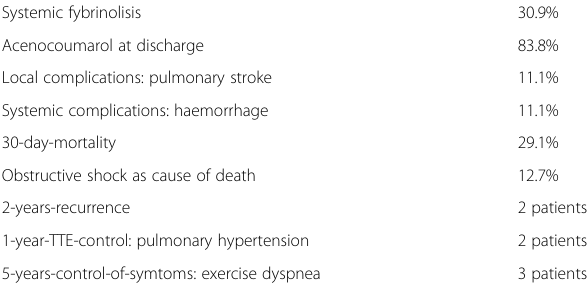
Table 3 (abstract 0326). Treatment, complications and